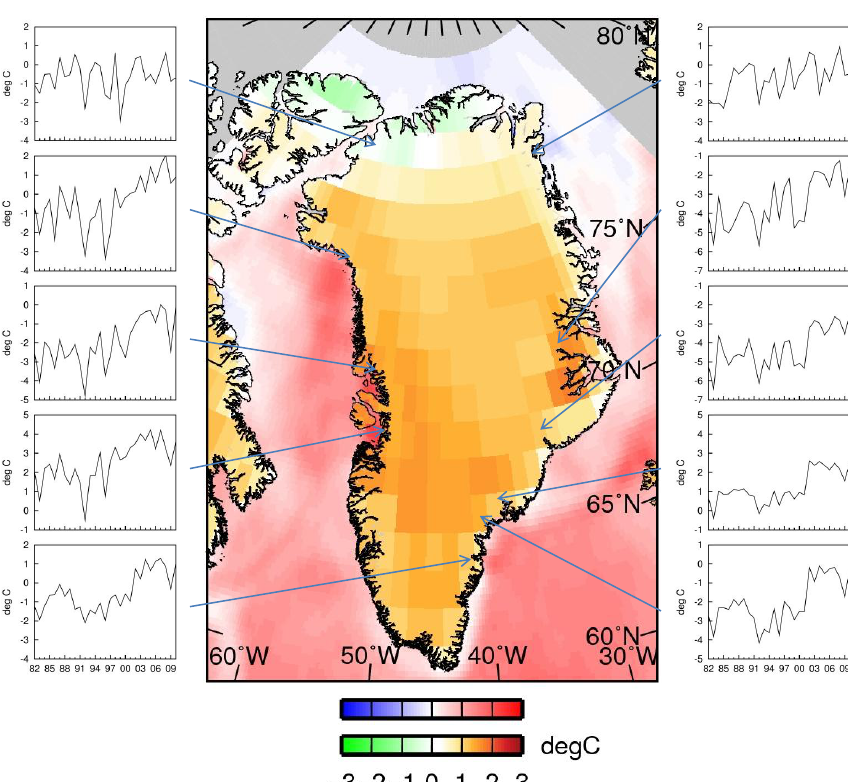
Fig. 2. Difference in mean summer temperature between and 1996–2010 and 1982–1995. Over land: ERA-Interim summer (June–August) 2m air temperature. Over ocean: OISST summer (July–September) sea surface temperature. The upper colour bar applies to the SSTs and the lower colour bar to the air temperatures. Surrounding plots show summer mean air temperatures from the ERA-Interim dataset for single pixels located over the lower few km of the indicated glacier